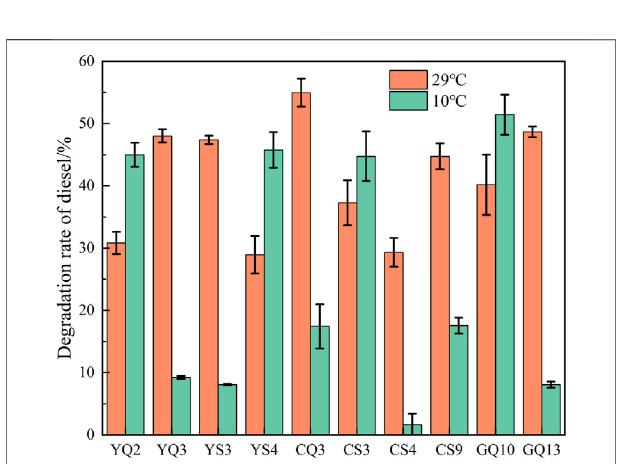
FIGURE 7 | Diesel degradation rate over 5 days by 10 strains.